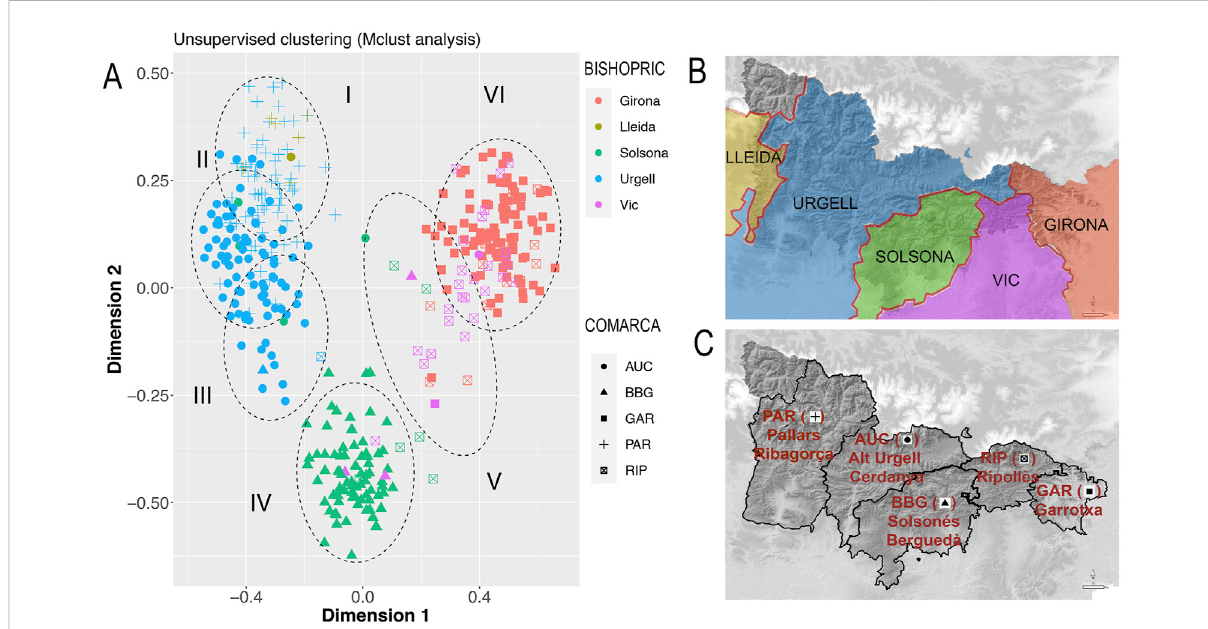
FIGURE 6 (A) Suggested clusters (ellipses I to VI) identi fi ed by applying theunsupervised clustering Mclust analysis. Colors identify bishoprics (Girona, red; Lleida, brown; Solsona, green; Urgell, blue and Vic, purple). Shape identify comarques (circles AUC, Alt Urgell-Cerdanya; triangles BBG, Berguedà- Solsonès; squares GAR, Garrotxa; crosses PAR, Pallars Jussà-Pallars-Sobirà-Ribagorça; crosses in squares RIP, Ripollès). (B) Colored bishoprics according to clustering, colors as in A. (C) Labeled comarques according to clustering, (circles AUC, Alt Urgell-Cerdanya; triangles BBG, Berguedà-Solsonès; squares GAR, Garrotxa; crosses PAR, Pallars Jussà-Pallars-Sobirà-Ribagorça; crosses in squares RIP, Ripollès).